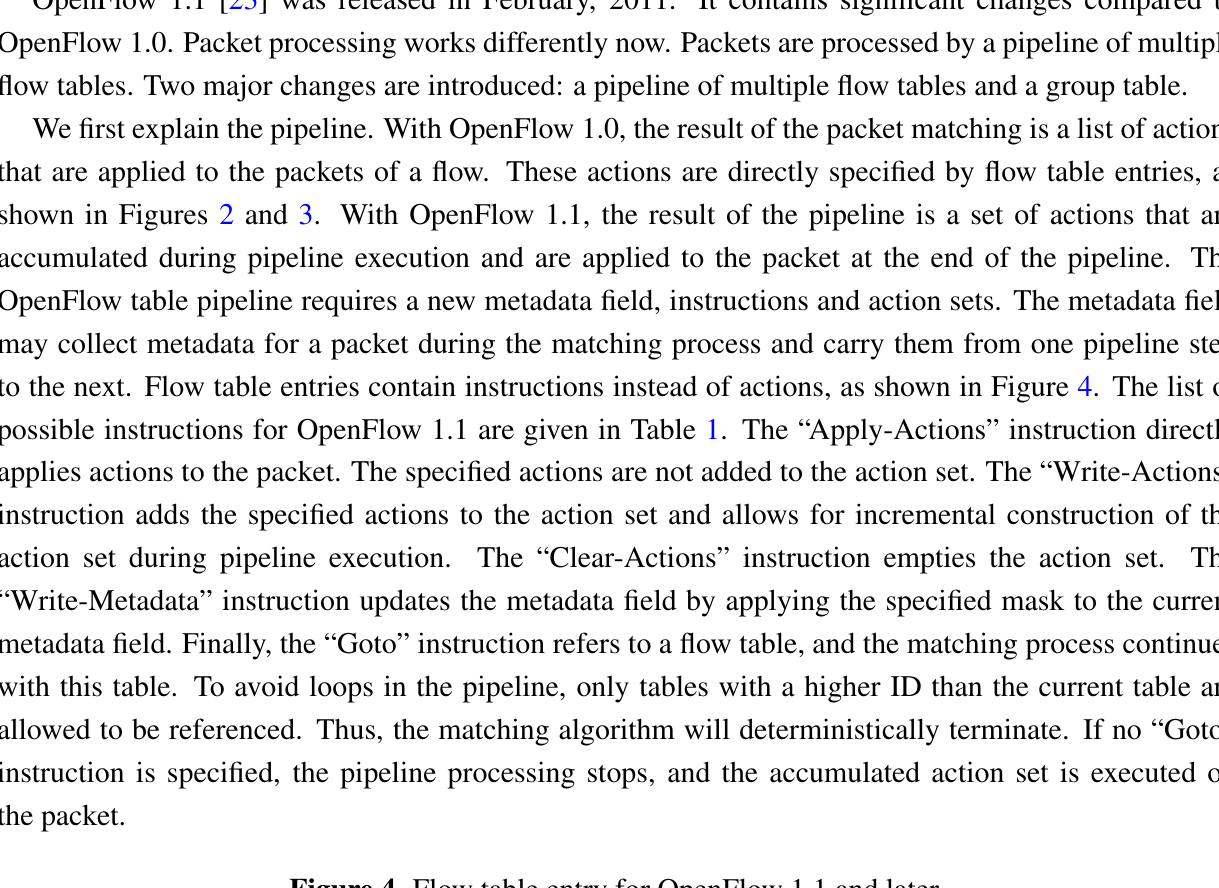
Figure 4. Flow table entry for OpenFlow 1.1 and later.